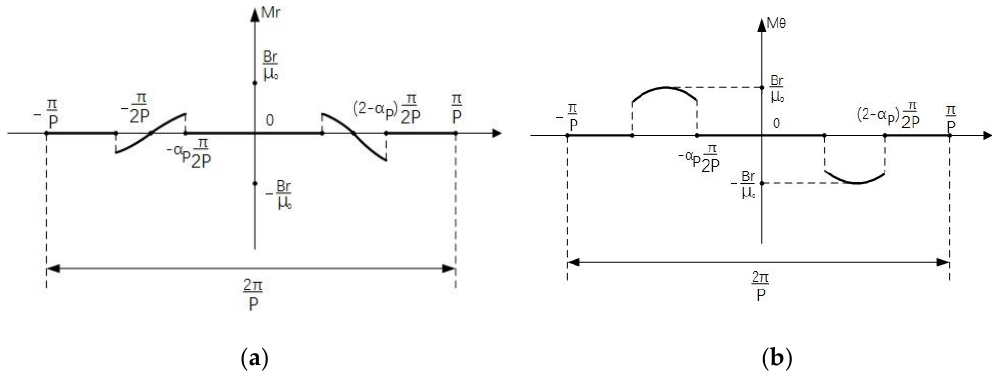
Figure 7. Magnetization of auxiliary pole: ( a ) radial component and ( b ) tangential component.